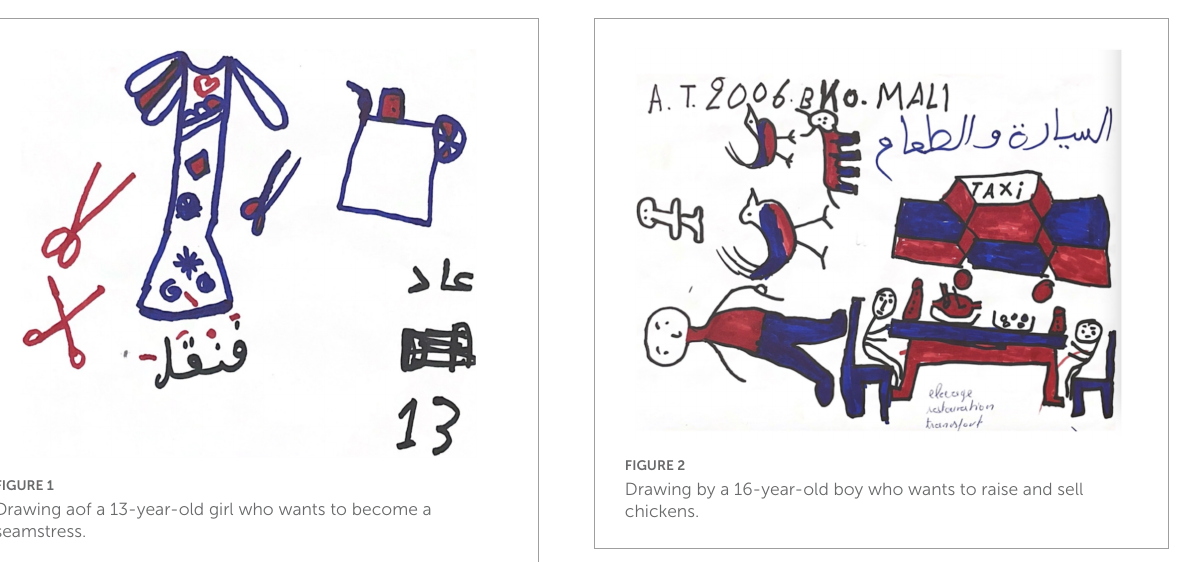
This is me here, sitting in front of a computer. I am a cashier.